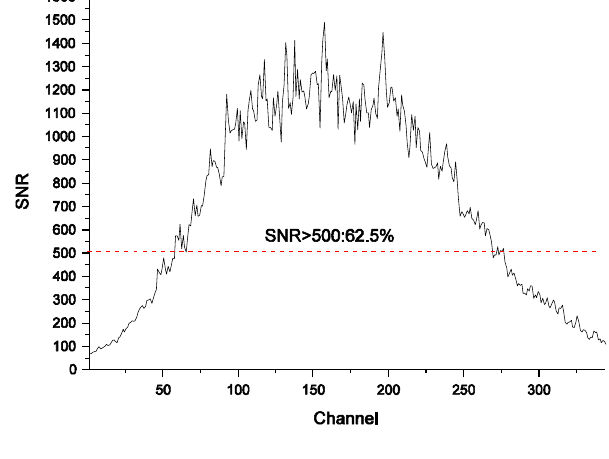
Figure 11. Maximum SNR of the FISS system for each channel: the abscissa is the channel number (band number), while the ordinate is the corresponding SNR calculated. The figure shoes that 215 of the 344 channels (62.5%) responded well, with SNR > 500 (above the dashed red